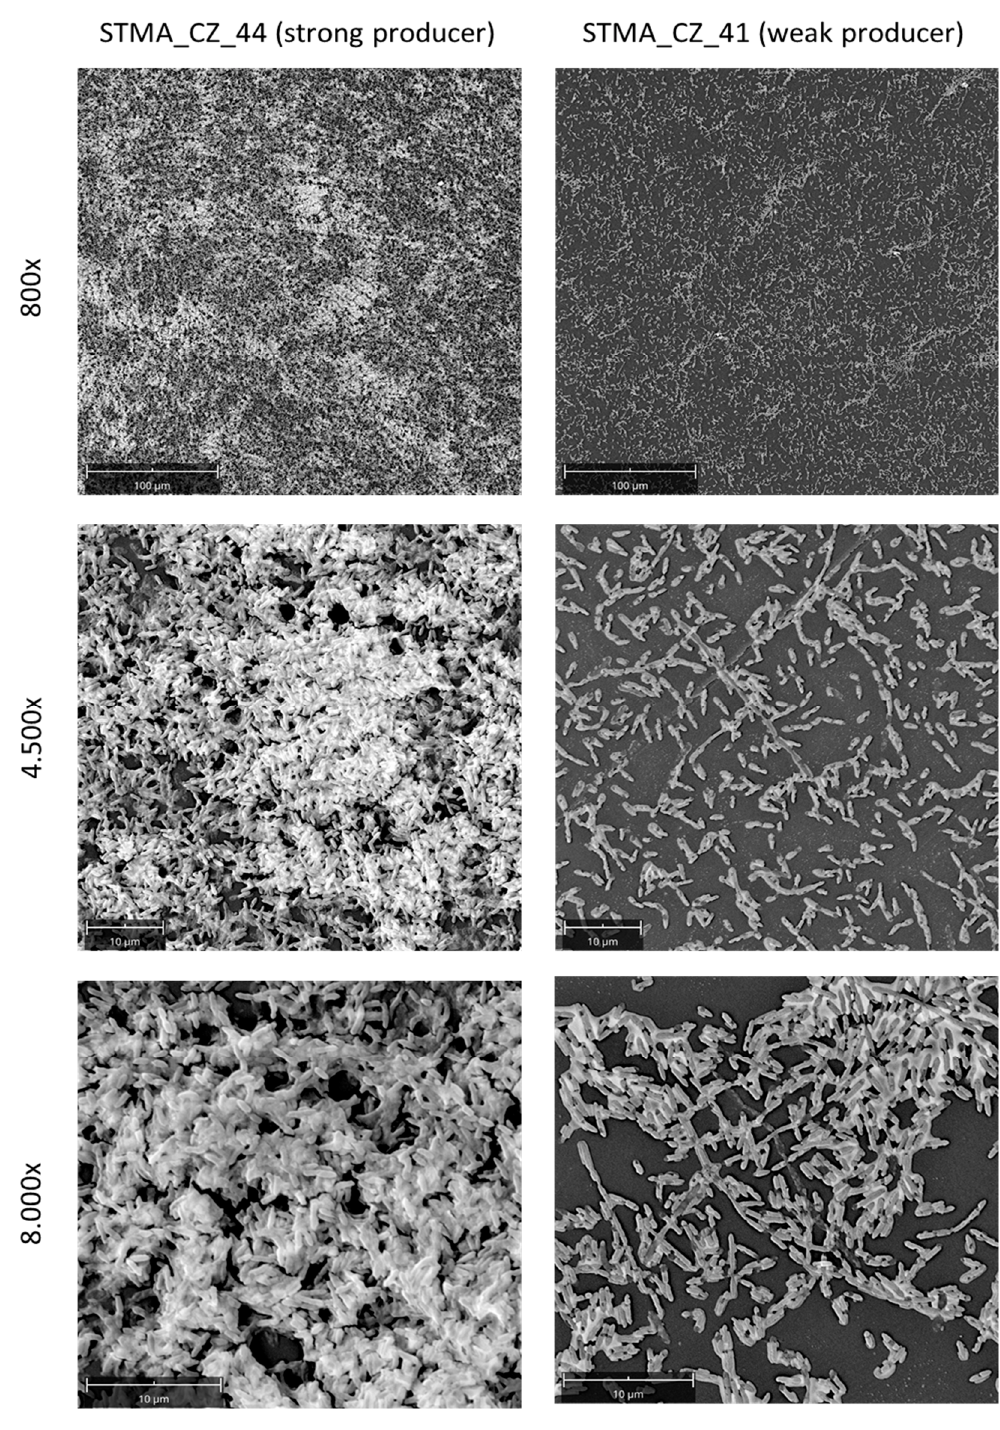
Figure 5. Ultrastructure analysis of S. maltophilia biofilm: scanning electron microscopy. The biofilm could form onto polystyrene coupons for 24 h at 37 °C by S. maltophilia STMA_CZ_44 and STMA_CZ_41 strains, representative of “strong” and “weak” biofilm-producer classes, respectively. Magnifications: 800×, 4500×, 8000×.